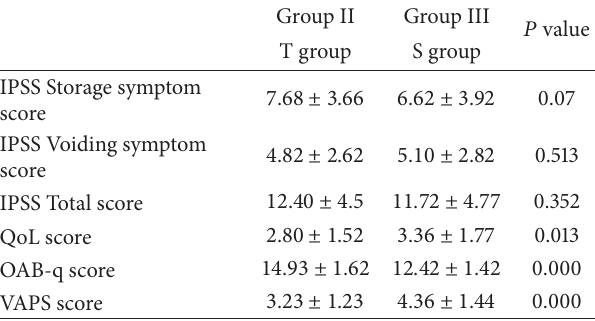
Table 3: Comparison between group II and III two weeks post insertion of Double-J